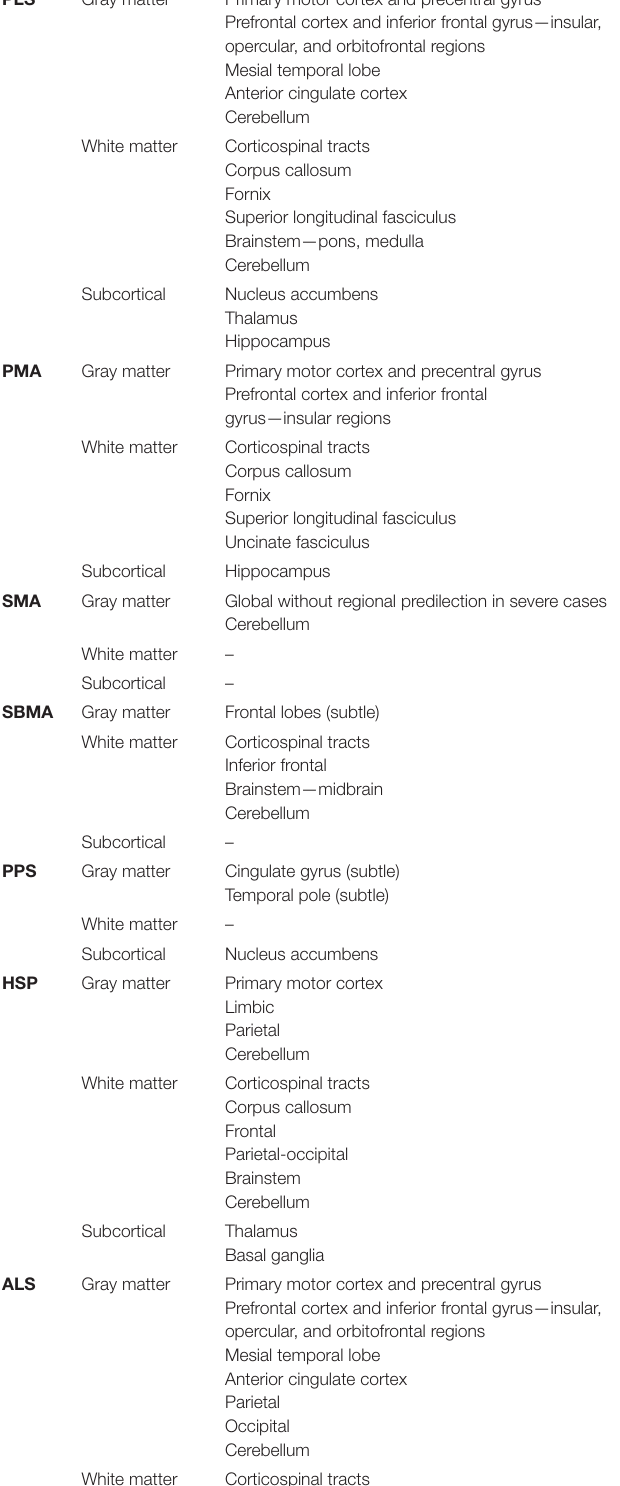
TABLE 4 | An overview of preferential anatomical involvement in MND phenotypes.